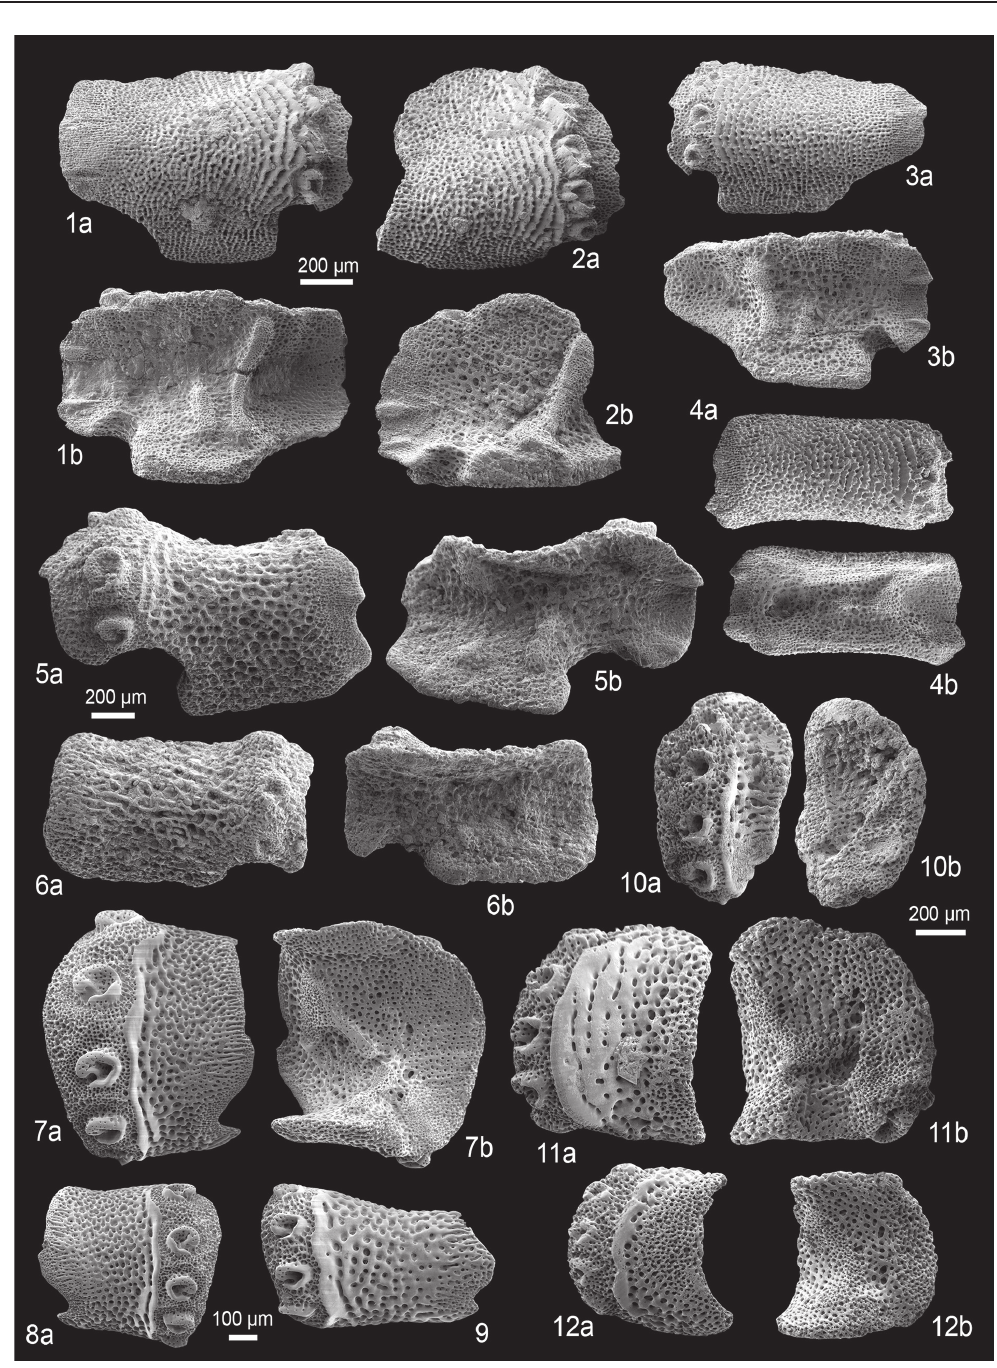
Fig. 31. Lateral arm plates (LAPs) of fossil and Recent ophiacanthid brittle stars in external (a) and internal (b) views. 1-4. Ishidacantha fuersichi gen. et sp. nov. from the Callovian (Middle Jurassic) of Jumara, India. 1. GZG.INV.78728 (holotype), proximal LAP. 2. GZG.INV.78729 (paratype), proximal LAP. 3. GZG.INV.78730 (paratype), median LAP. 4. GZG.INV.78731 (paratype), distal LAP. 5-6. Ishidacantha trispinosa (Hess, 1965) comb. nov. from the early Oxfordian (Late Jurassic) of Longecombe, France. 5. NHMB M11222, proximal LAP. 6. NHMB M11223, distal LAP. 7-9. Ophiomitrella conferta (Koehler, 1922), Recent. 7. Proximal LAP. 8. median LAP. 9. distal LAP. 10-12. Ophiomitrella ? sp. 1 from the Callovian of Bauer-Wehrland, Germany. 10. GZG.INV.78735, proximal LAP. 11. GZG.INV.78736, median LAP. 12. GZG.INV.78737, distal LAP. One common scale bar per